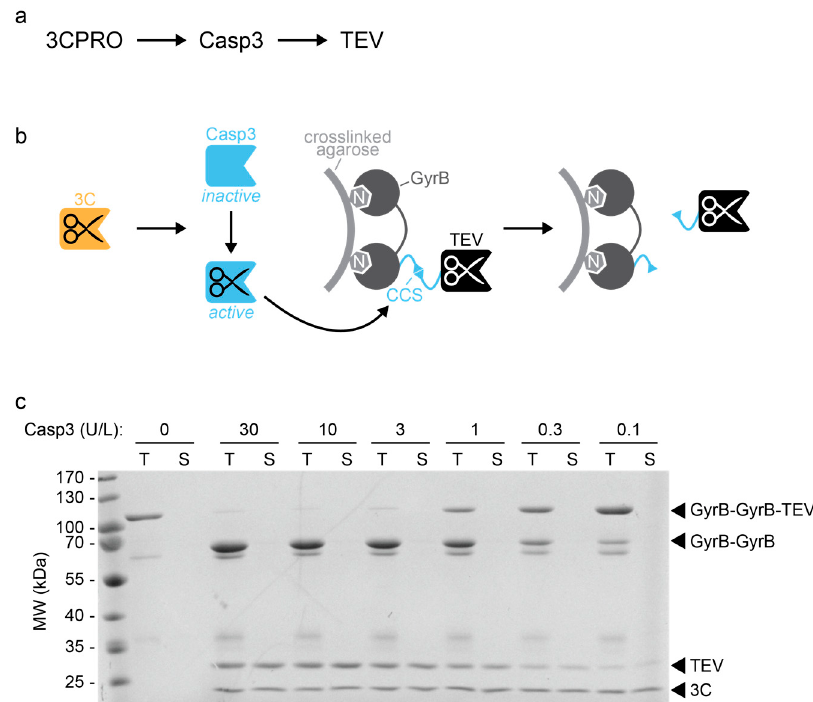
Figure 3. Engineering of a three-tiered protease cascade. ( a ) Sequence of the protease cascade comprised of the 3C protease (3CPRO), CASP3, and TEV protease. ( b ) Schematic representation of the design. The TEV protease is fused via a CASP3-cleavable linker (CASP3 cleavage site, CCS) to a bacterial gyrase subunit B (GyrB) tandem for its immobilization to novobiocin (N)-functionalized agarose. In the presence of 3C protease (3C), CASP3 is activated and triggers the release of the TEV protease from the solid support. ( c ) Testing of the designed protease cascade. An equivalent of 13 mg / mL TEV-agarose (corresponding to 2.2 µ M TEV) was incubated in the absence of upstream proteases (lane 1 and 2) or in the presence of 3C protease (4.8 µ M) and the indicated concentrations of inducible CASP3 (3CS_ins; lane 3–14; 1 U / L corresponded to 0.017 µ M CASP3) overnight at RT. The cleavage and release of the